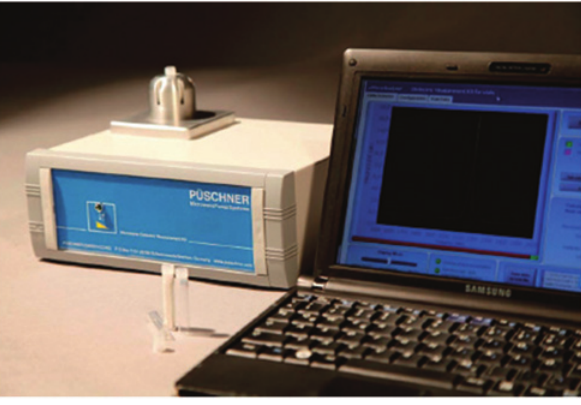
Figure 4: Zinc oxide dust dielectric constant measurement device